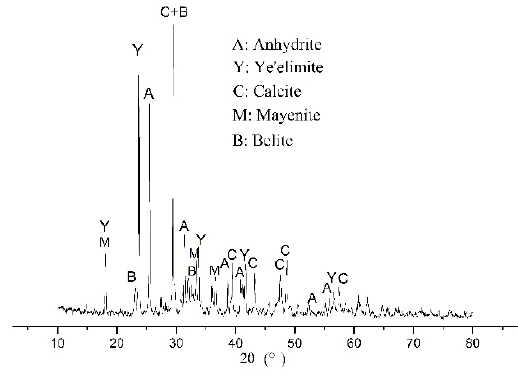
Figure 1. XRD patterns of the CSA cement.